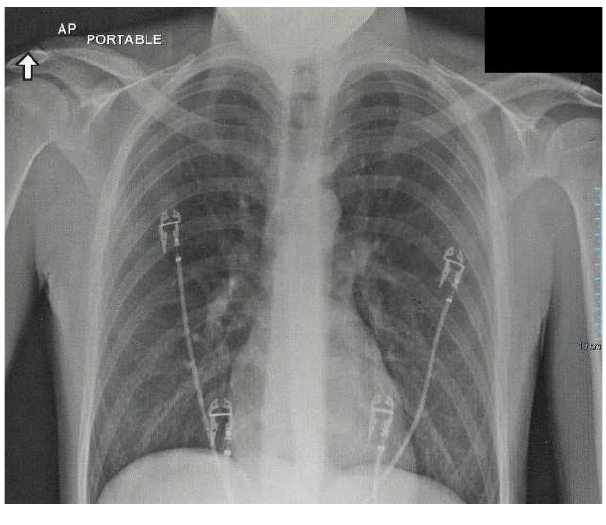
Table 1 . Laboratory Investigation and Results: Basic Metabolic